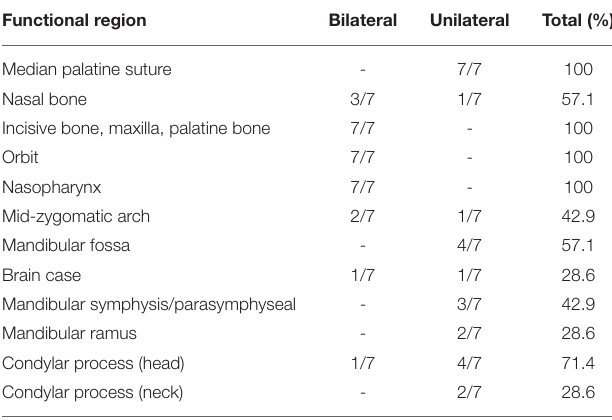
TABLE 3 | Functional regions * fractured in seven cats with acquired midline PDE that had computed tomography (CT). Functional region